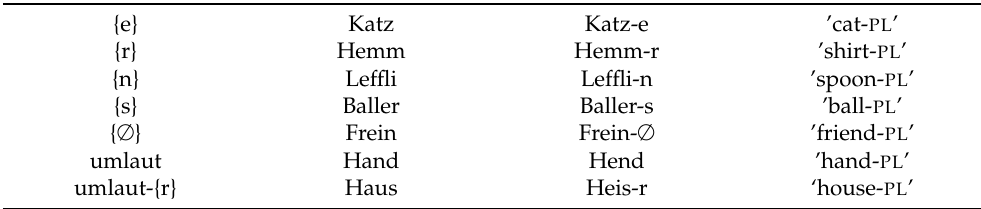
Table 1. Pennsylvania Dutch plural